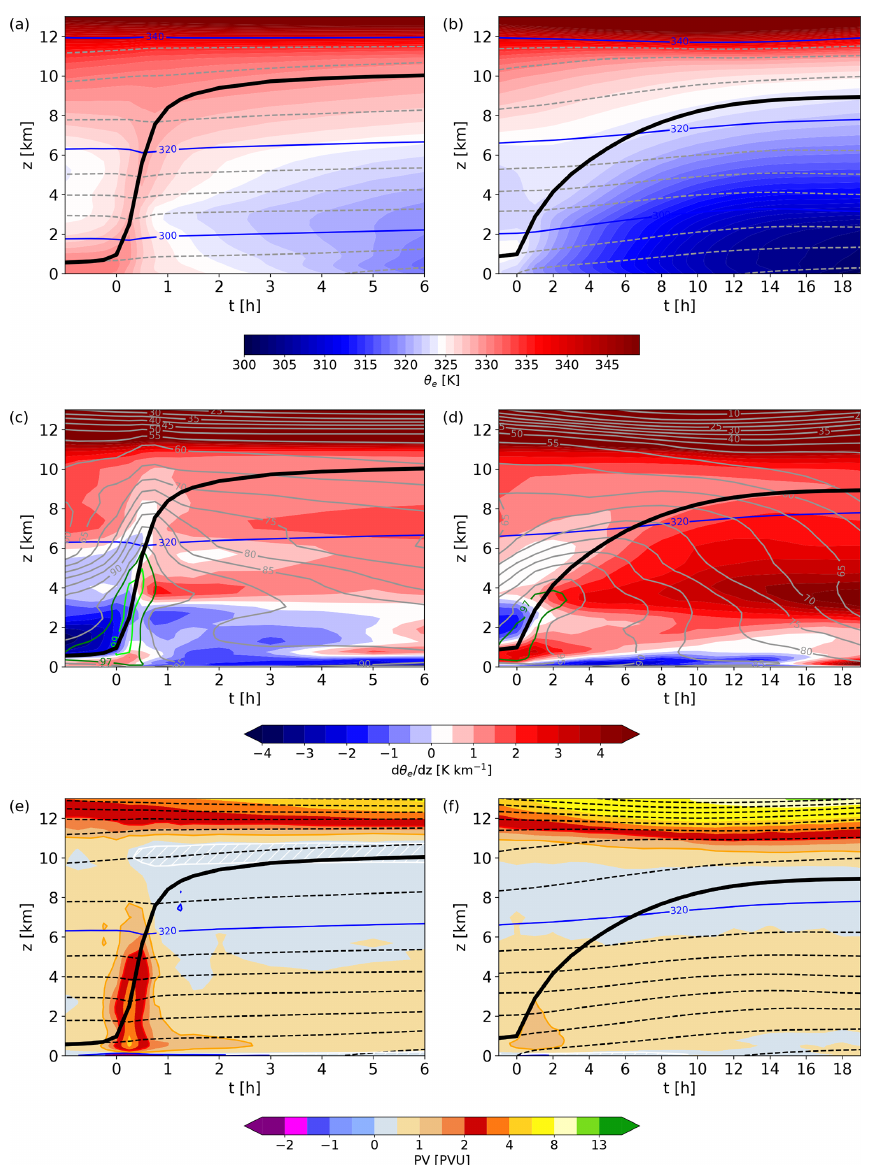
Figure 5. Composites of vertical profiles following the motion of the trajectories (the black line shows the mean ascent of all WCB trajec- tories) for (a, c, e) convective WCB trajectories and (b, d, f) slantwise WCB trajectories. The fields shown are (a, b) equivalent potential temperature ( θ e , colors, in K); potential temperature ( θ , dashed grey lines, every 5K); and the 300, 320, and 340K isentrope (blue lines); (c, d) moist stability (d θ e / d z , colors, in Kkm − 1 ), the 320K isentrope (blue line), and relative humidity (RH, grey contours, in %; 97% and 99% RH contours are highlighted in green and lime); (e, f) PV (colors, in PVU), isentropes (dashed lines, every 5K), the 320K isentrope (blue line), and in (e) low static stability layers (d θ/ d z ≤ 2Kkm − 1 , white contour and hatching). Note the different time axis in (a, c, e) and (b, d, f)